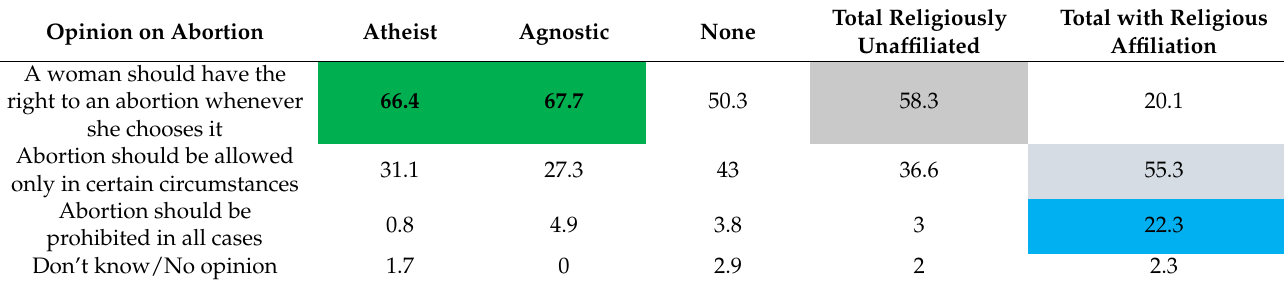
Figure 5. Appraisal of Pope Francis (in %). Based on 382 cases. Source: Author’s elaboration based on the Second National Survey on Religious Beliefs and Attitudes. Society, Culture and Religion Program, CEIL-CONICET, 2019. Table 3. Opinion on